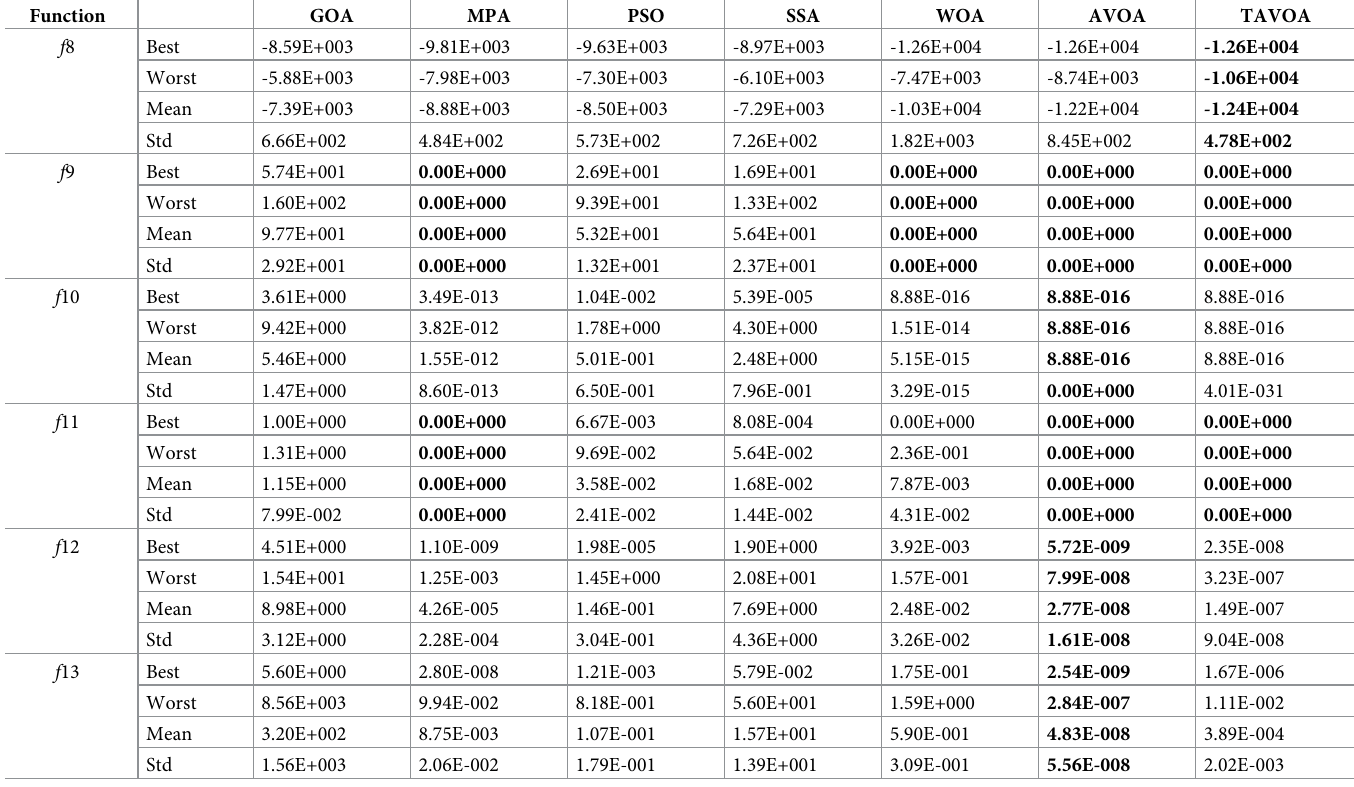
Table 4. Experimental results of basic multi-modal benchmark functions ( f 8 − f